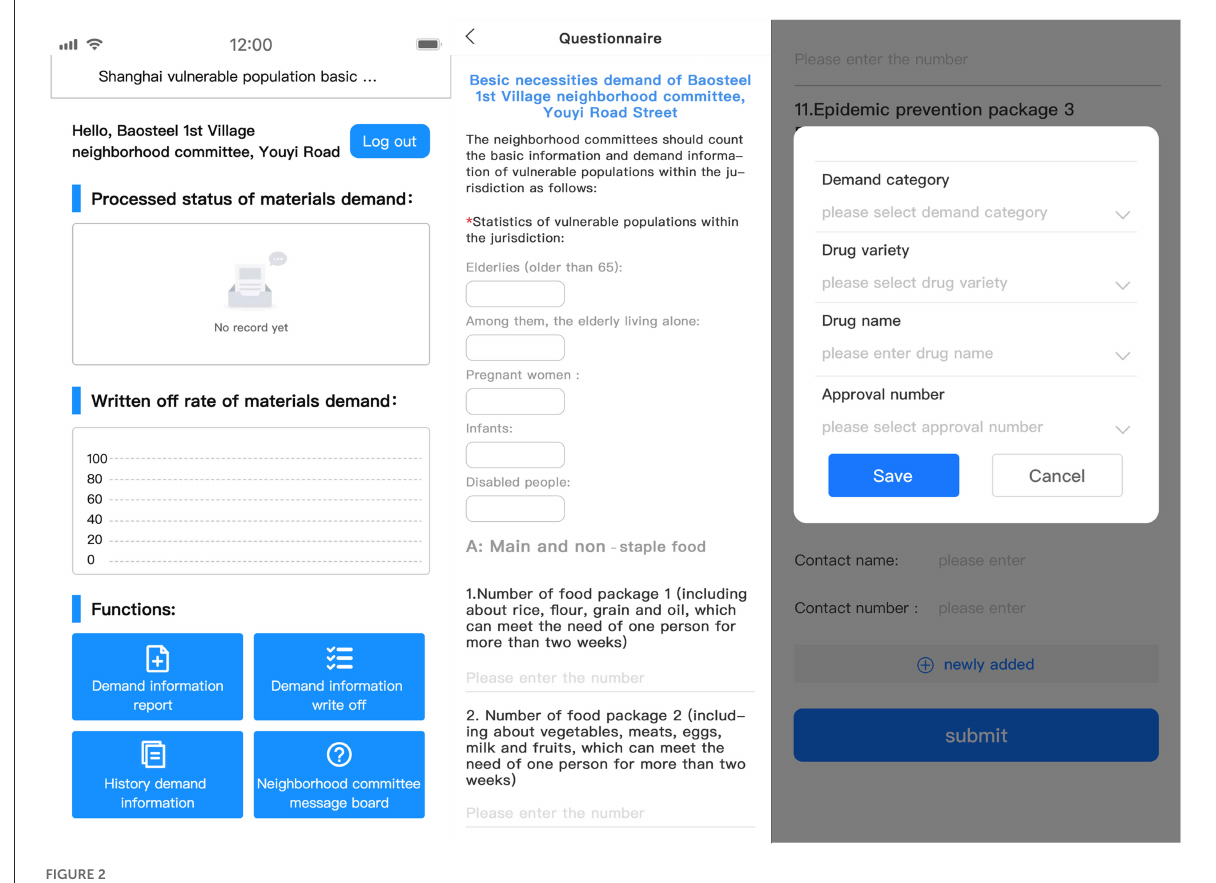
FIGURE2 Illustration of the demand collection interface used by communities (mobile app side).